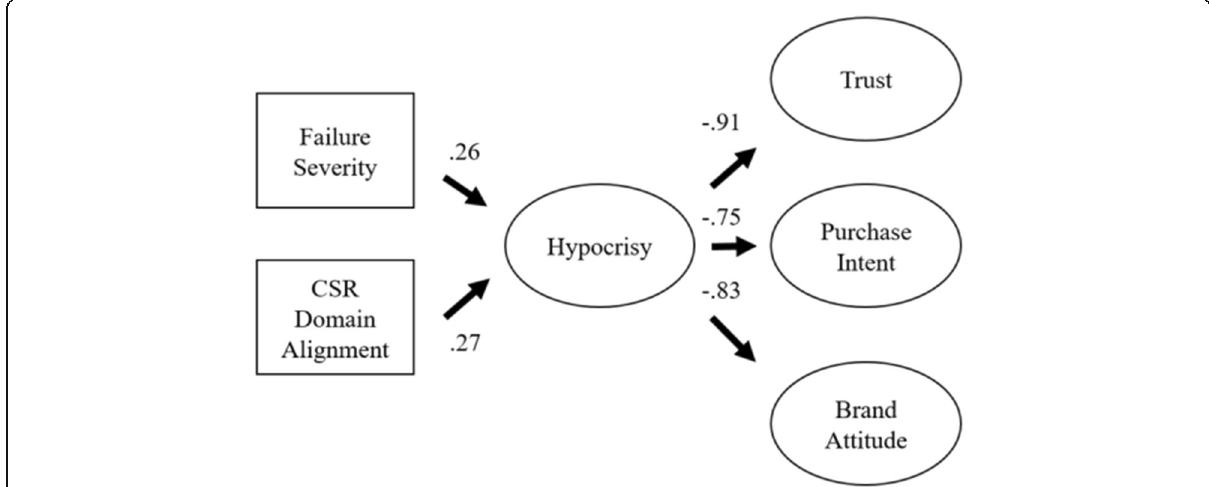
Fig. 1 Results of SEM